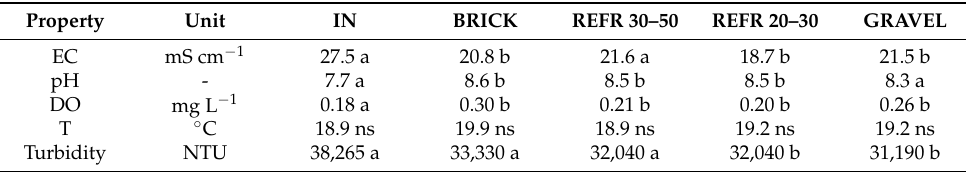
Table 2. The eight-week median values of electrical conductivity (EC), pH, dissolved oxygen (DO), temperature (T), and turbidity of digestate at the inlet (IN) and filter outlets. Different letters indicate significant differences at p < 0.05 using the Kruskal–Wallis